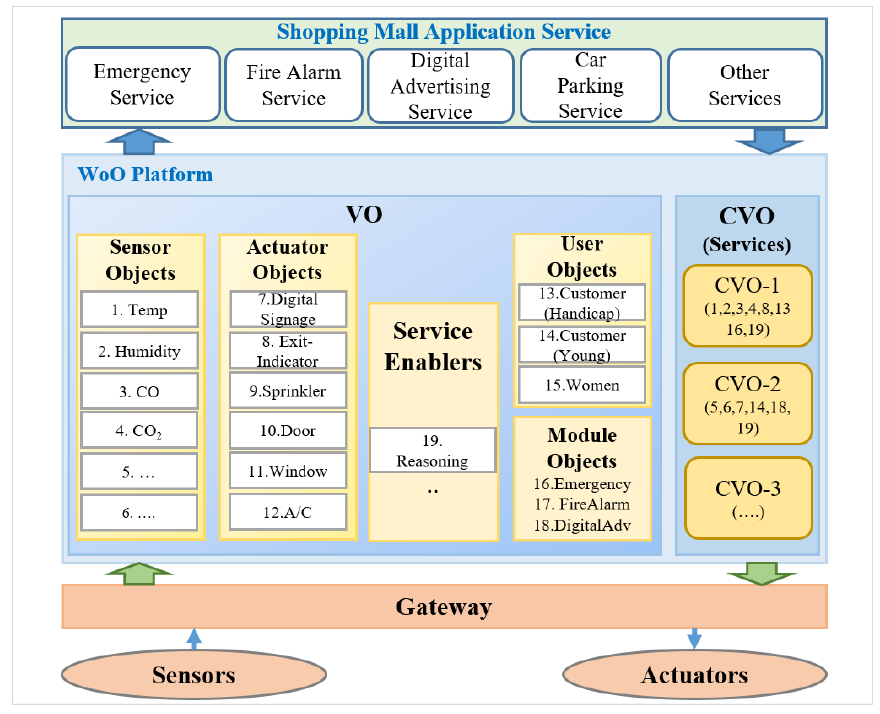
Figure 13. Use case of service composition on a WoO